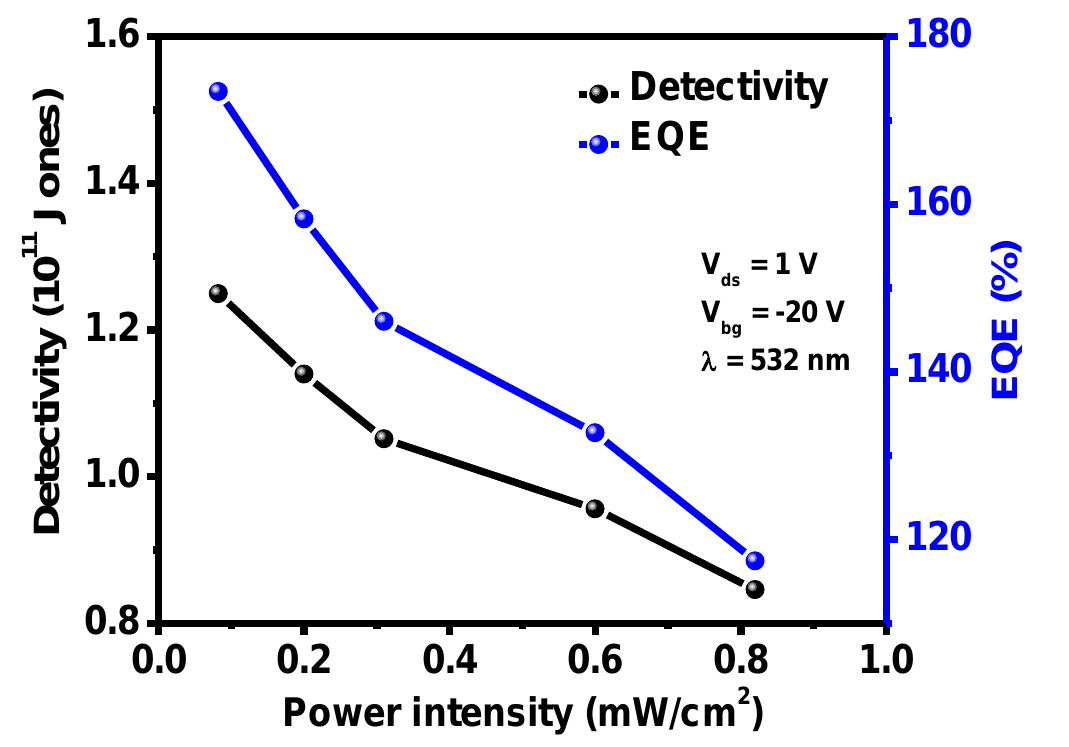
Figure 4. Calculation of detectivity (D*) and external quantum efficiency (EQE%) measured at V ds = 1V, V bg = −20 V, and λ = 532 nm.